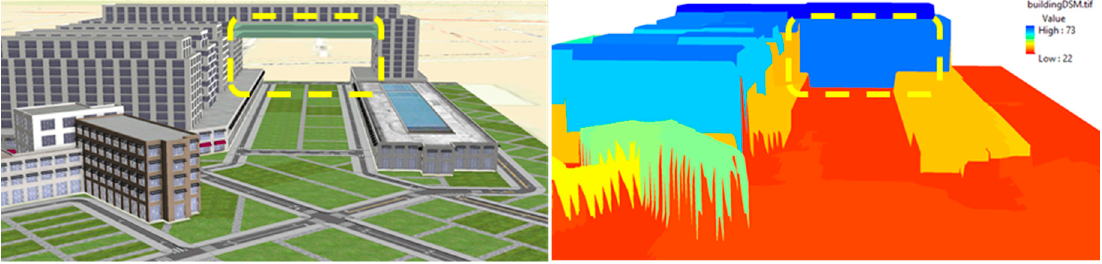
Figure 6. Open space as a part of 3D building geometry interpolated with elevation cell values in its DSM.